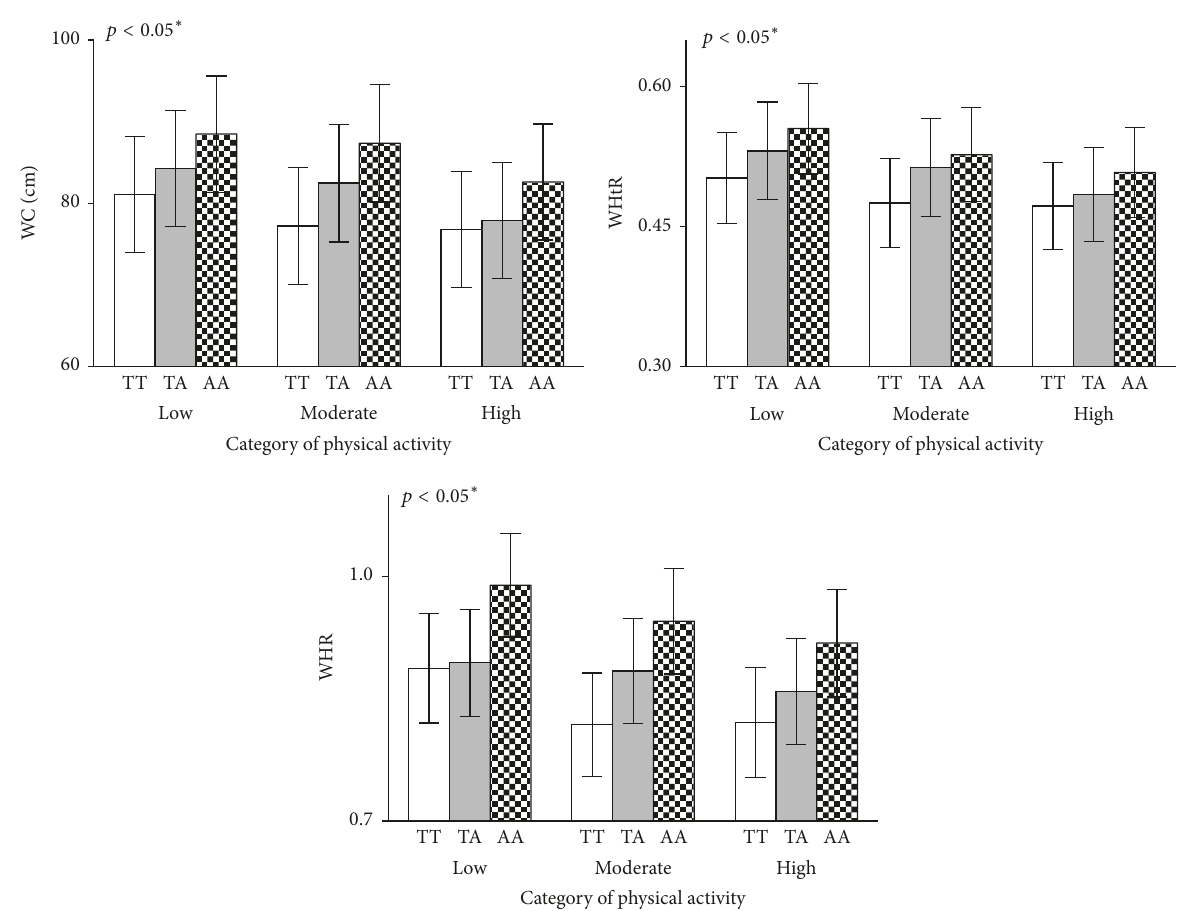
Figure 3: Effect of the FTO rs9939609 genotype on adiposity measures (WC, WHtR, and WHR) stratified by category of PA. 𝑝 values are for the interaction between the FTO variant and PA category; least-squares means of different genotypes across all PA groups were calculated using Robust Linear Regression analysis, with adjustment for age and sex. Allele frequency by PA category was low: 20/43/14; moderate: 28/34/13; high: 27/13/9 for TT, TA, and AA genotypes, respectively. WC: waist circumference, WHtR: waist to height ratio, and WHR; waist to hip ratio. ∗ Mean of each variable with genotype for high PA is different from the mean of each genotype for low PA at 𝑝 < 0.05 but not in WC AA genotype and WHR TA